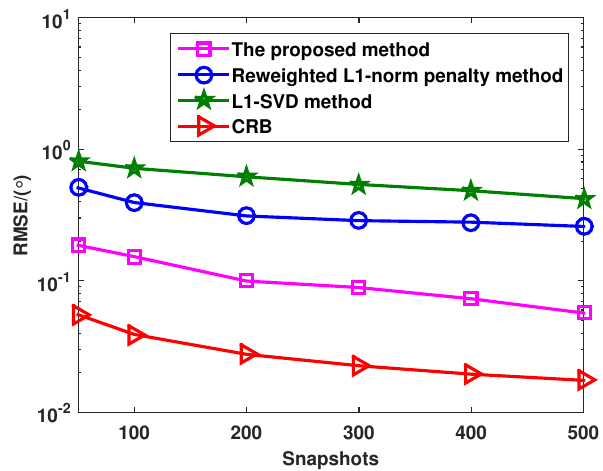
Figure 4. RMSE of the l 1 -SVD method, the reweighted l 1 -norm penalty method and the proposed method when the snapshots varies from 50 to 500.